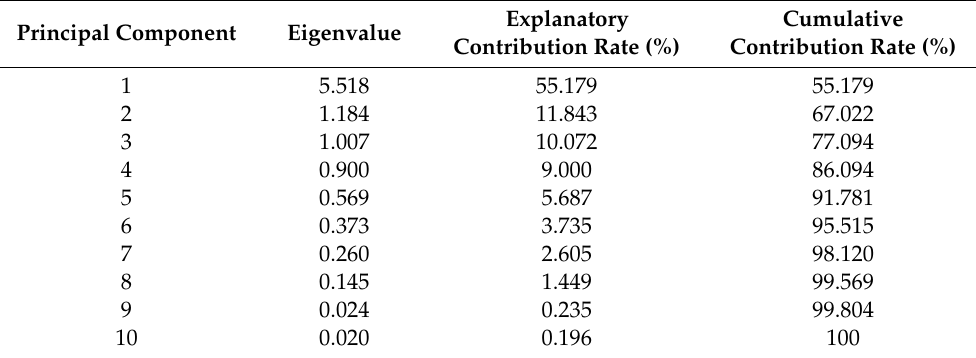
Table 1. Eigenvalues and explanatory contribution rates of all principal components.